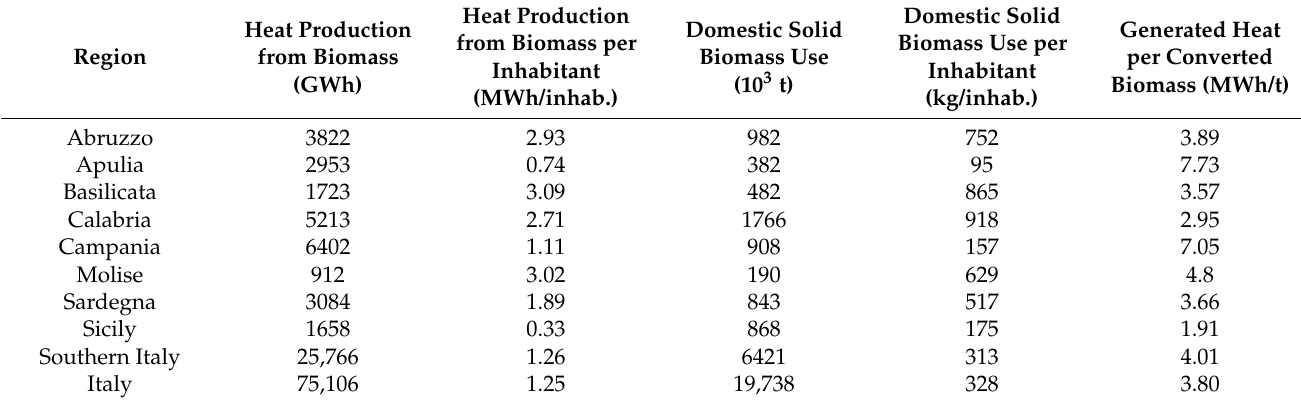
Domestic Solid Generated Heat Domestic Solid Biomass Use per per Converted Biomass Use Inhabitant Biomass (10 3 t) (kg/inhab.)